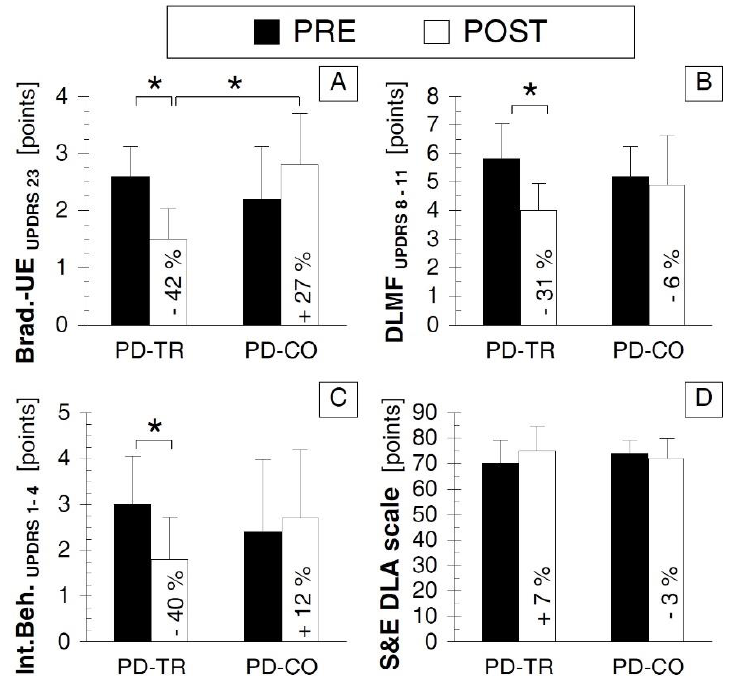
Figure 5. Comparison of neurological outcomes between the two testing sessions and two tested groups. ( A ) panel A presenting the values of Brad.-UE UPDRS 23 ; ( B ) panel B presenting the values of